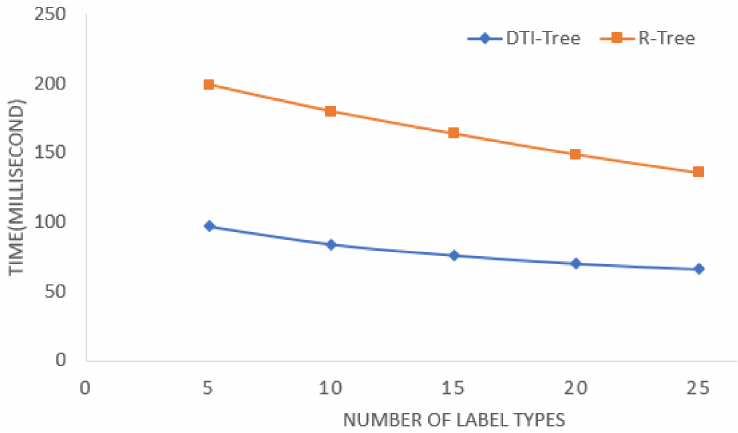
Figure 16. Similarity query performance (label types).